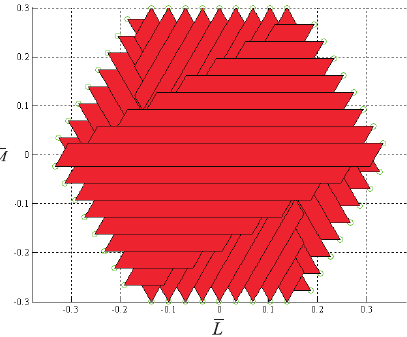
Figure 7: Reference set-points { ¯ L; ¯ M } (blue circles) and corre- sponding admissible polygons { ¯ L; ¯ M } (red quadrilaterals) with a; b; c